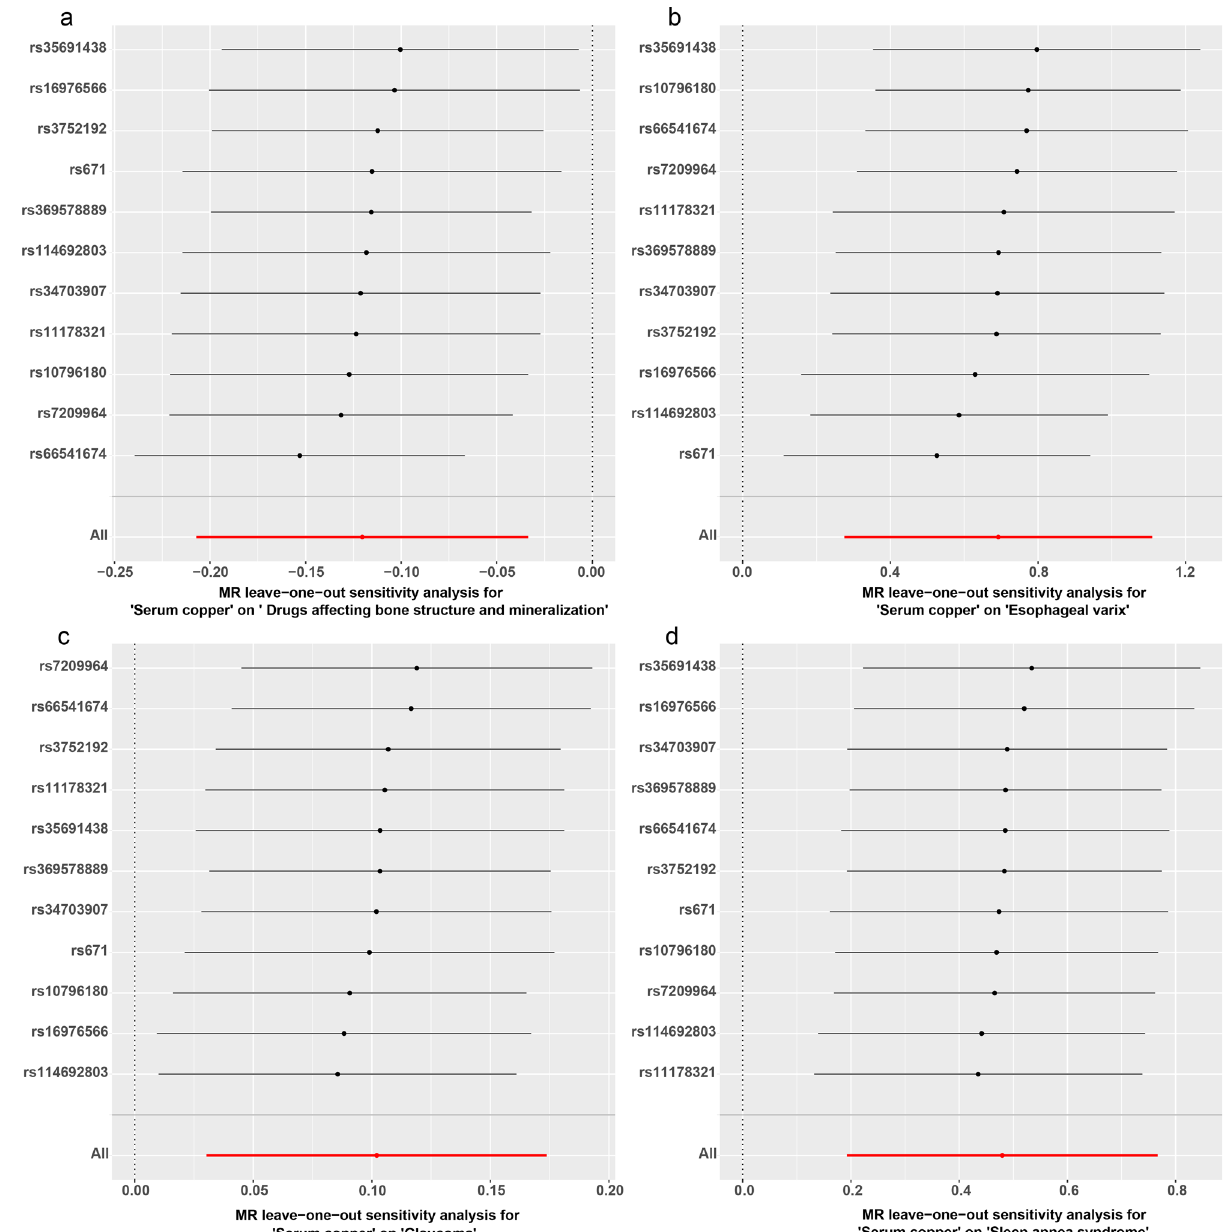
Fig. 3 Plots of leave-one-out analyses for four robust results in the fi rst round two-sample Mendelian randomization analyses. The error bars indicate the 95% con fi dence interval. a Usage of drugs affecting bone structure and mineralization. b Esophageal varix. c Glaucoma. d Sleep apnea syndrome. MR Mendelian